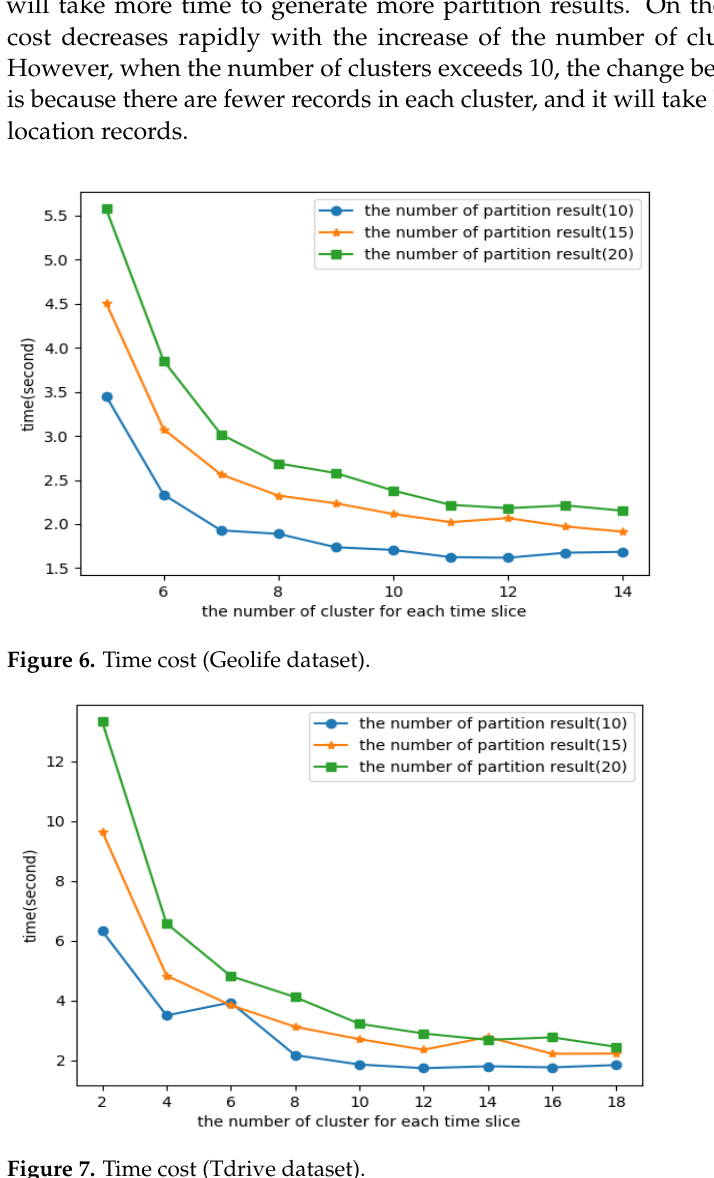
Figure 7. Time cost (Tdrive